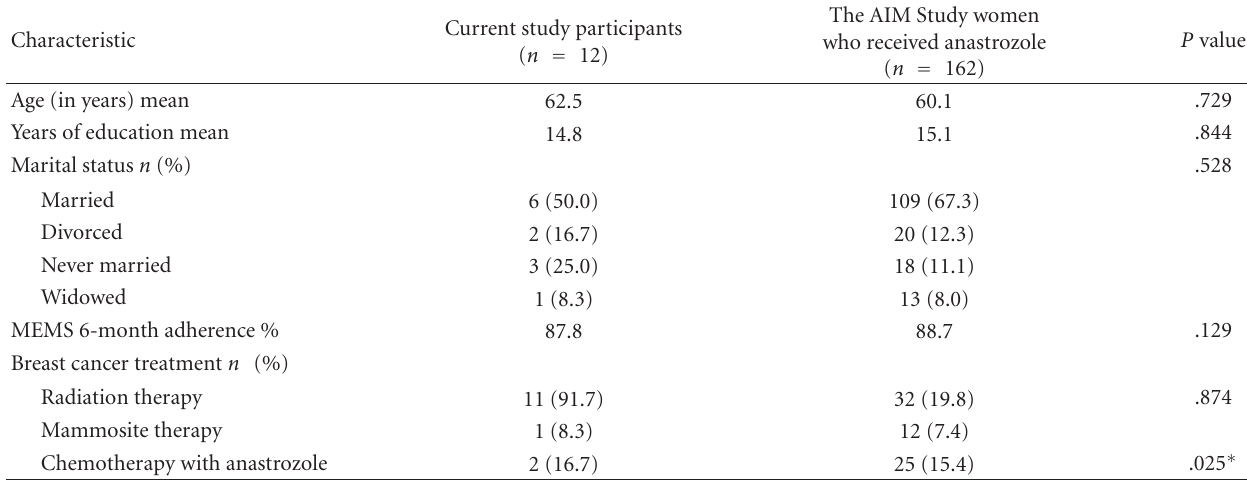
Table 1: Participant sociodemographic, breast cancer, and breast cancer treatment